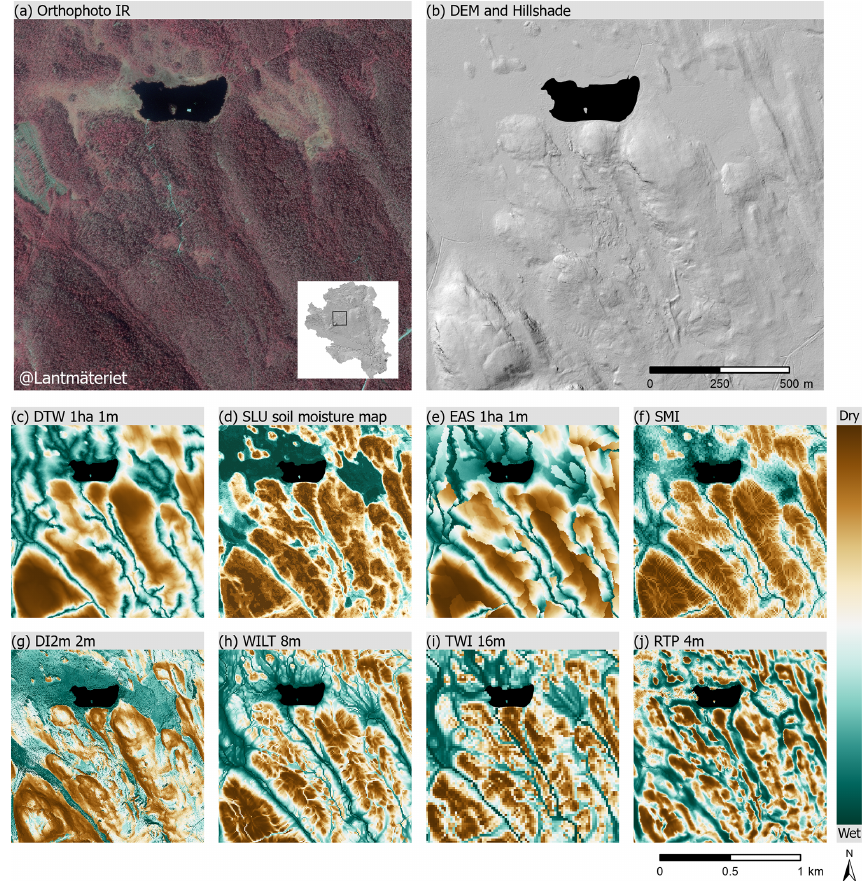
Figure 4. Orthophoto (© Lantmäteriet) (a) and hill-shaded DEM (b) covering a till area within the Krycklan catchment. Below, maps of the highest-performing maps of different terrain indices in order of VIP predictive with simplified common symbology for terrain indices (c–j) based on value distribution for the visual